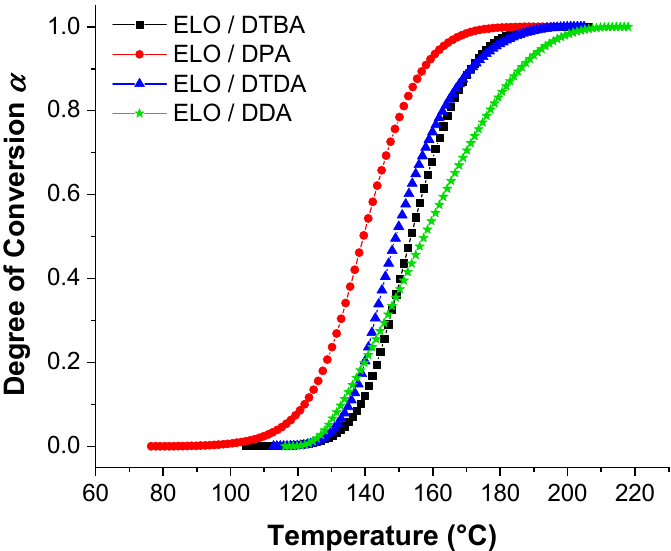
Figure 4. Degree of conversion vs. temperature for the reference resin in function of the crosslink- ers.